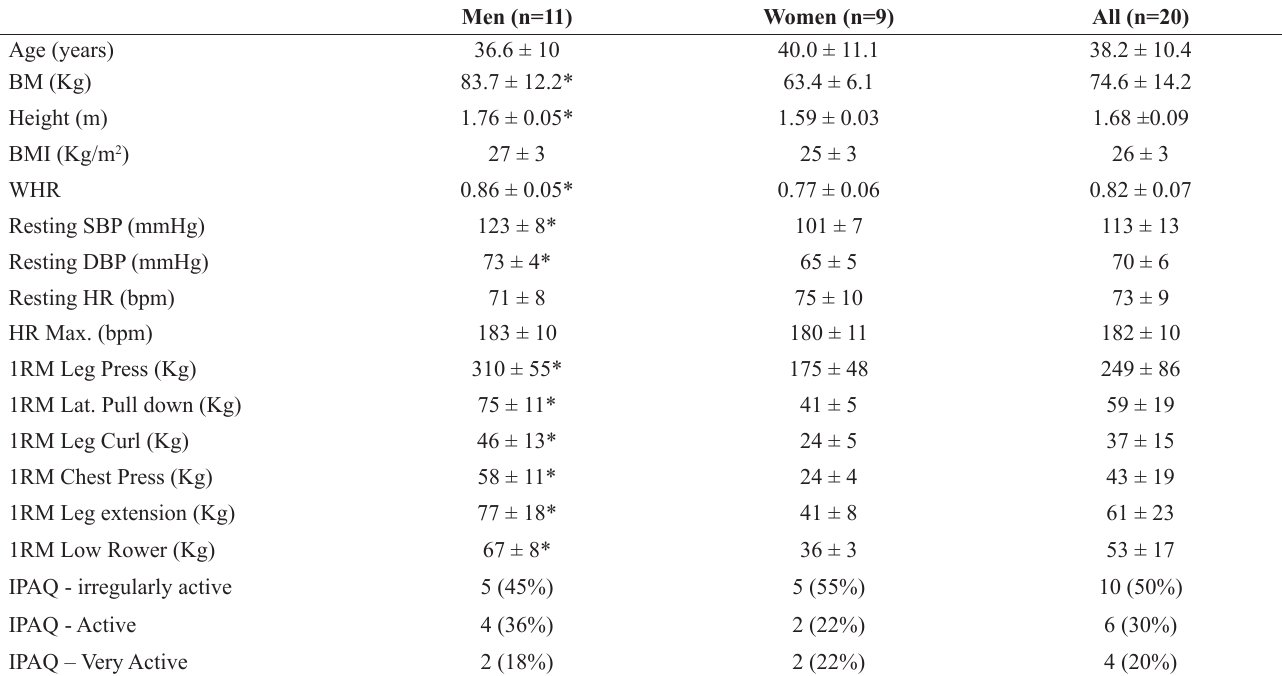
Table 1. General characteristics of all